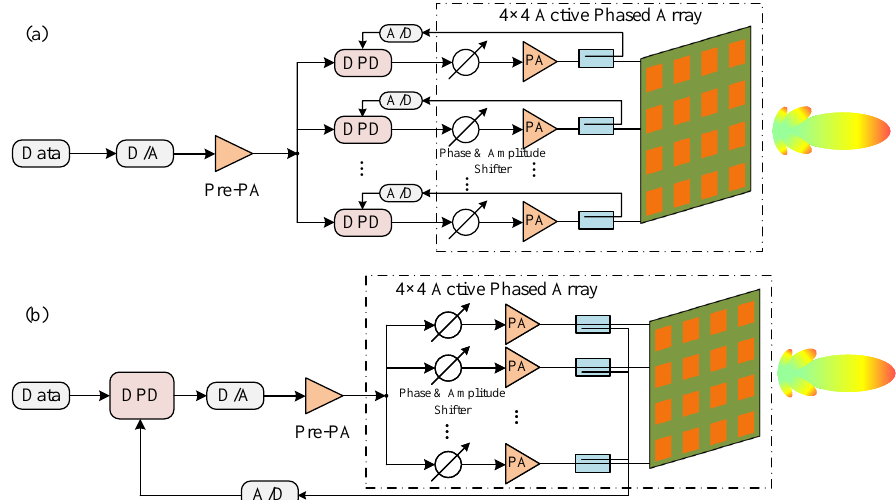
Figure 1. Block diagram of DPD structure of conventional two categories of array antennas: ( a ) one- to-one DPD; ( b ) overall